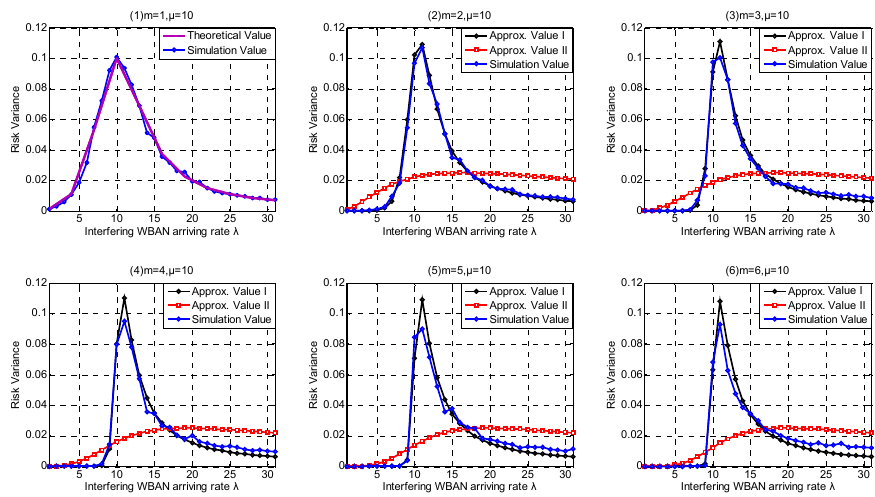
Figure 17. Risk Variance in Service-dependent coexisting